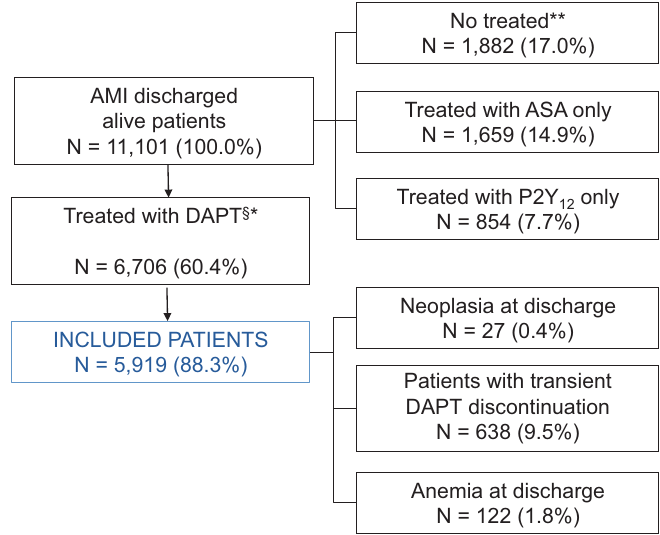
Fig. 1 Flow chart for patient selection and inclusion and exclusion criteria for study. DAPT, dual-antiplatelet therapy; AMI, acute myocardial infarction; ASA, acetylsalicylic acid. Notes : § DAPT ¼ ASA þ P2Y 12 inhibitors (clopidogrel, prasugrel, ticagrelor, ticlopidine); (cid:1) At least one prescription of ASA and at least one prescription of P2Y 12 in the month following hospital discharge; (cid:1)(cid:1) Any prescription of ASA or P2Y 12 in